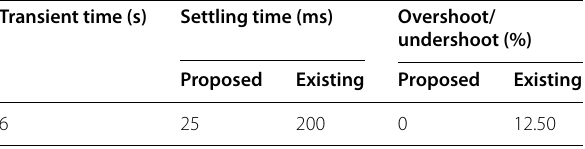
Table 5 Quantitative analysis for DC load